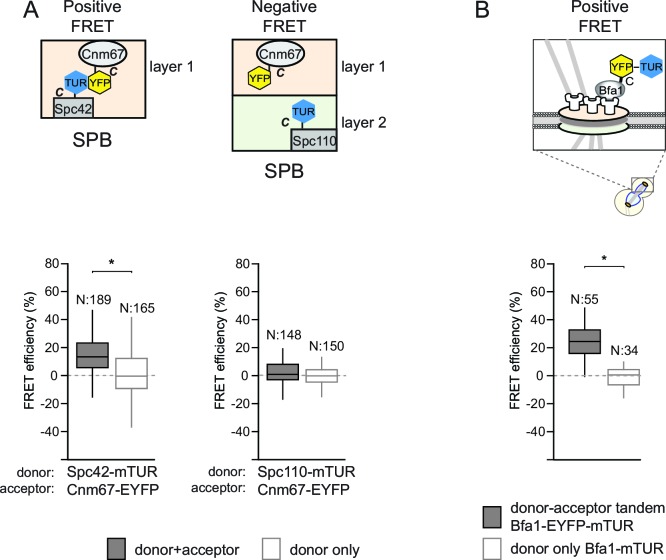
Validation of acceptor photobleaching technique with FRET-positive and FRET-negative controls.(A–B) Box-Whisker plots representing the distributions of FRET efficiencies measured in pairs of fluorescently tagged proteins: Spc42-Cnm67 (FRET-positive pair) and Spc110-Cnm67 (FRET-negative pair) (A) and in the tandem pair of EYFP and mTUR in fusion with Bfa1 (B). Box-whisker plot is one out of two technical replicates from the same experiment. N: sample size. Asterisks show significant difference according to student’s t-test (p<0.01). See the accompanying data file for exact p-values (Figure 1—figure supplement 2—source data —1 and 2).DOI:
http://dx.doi.org/10.7554/eLife.14029.00610.7554/eLife.14029.007Figure 1—figure supplement 2—source data 1.Raw and calculated FRET efficiencies of Spc42-Cnm67 and Spc110-Cnm67 pairs at SPBs in cycling cells (source data for Figure 1—figure supplement 2A).DOI:
http://dx.doi.org/10.7554/eLife.14029.00710.7554/eLife.14029.008Figure 1—figure supplement 2—source data 2.Raw and calculated FRET efficiencies of Bfa1-EYFP-mTUR tandem pair at SPBs in cycling cells (source data for Figure 1—figure supplement 2B).